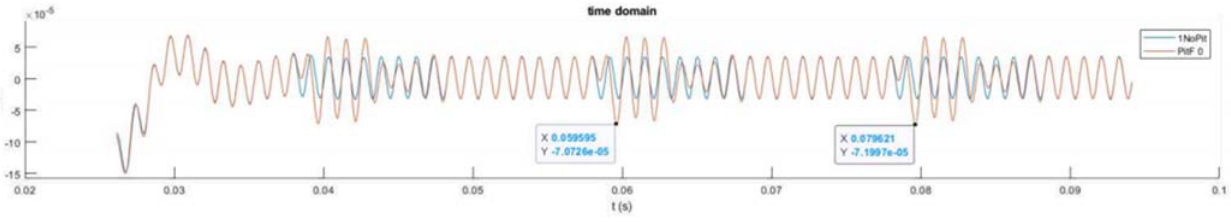
Figure 9. Comparison of the vibrational spectra on one bearing between the healthy transmission and the damaged one (time domain).